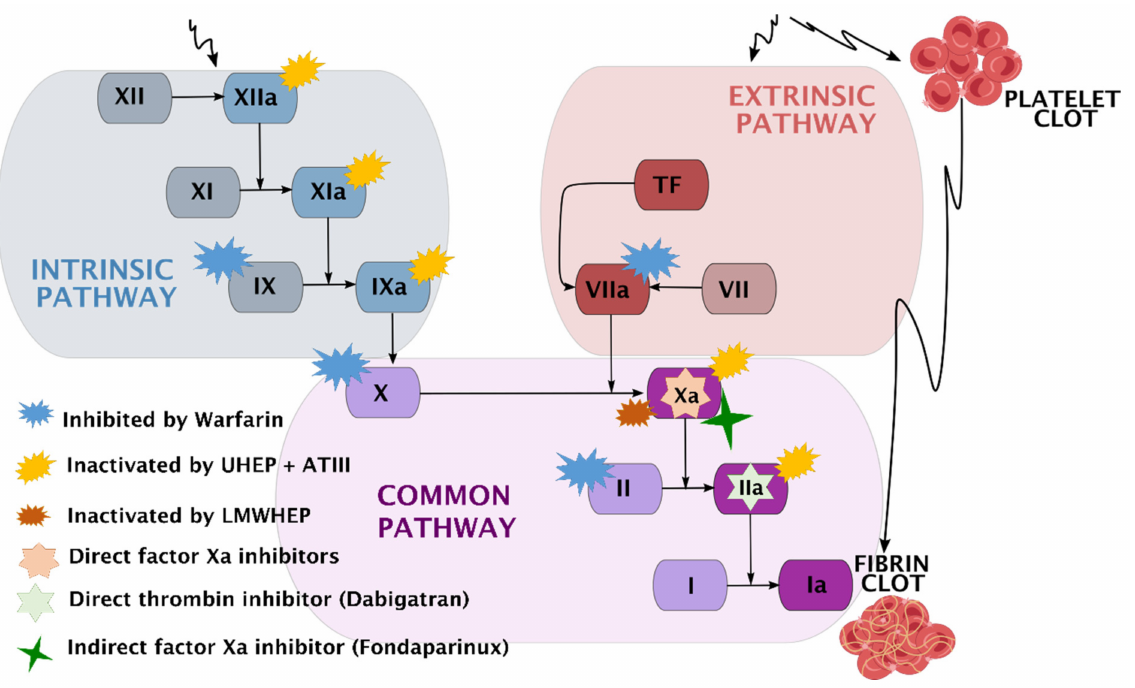
Figure 5. An overall presentation of the coagulation pathway and the sites of action of anticoagulants used in clinical practice. The coagulation factors are represented by Roman numerals, and the letter “a” indicates their activated form. Adopted after Dwivedi and Pomin [207], Gando et al. [208], and Jay and Lui